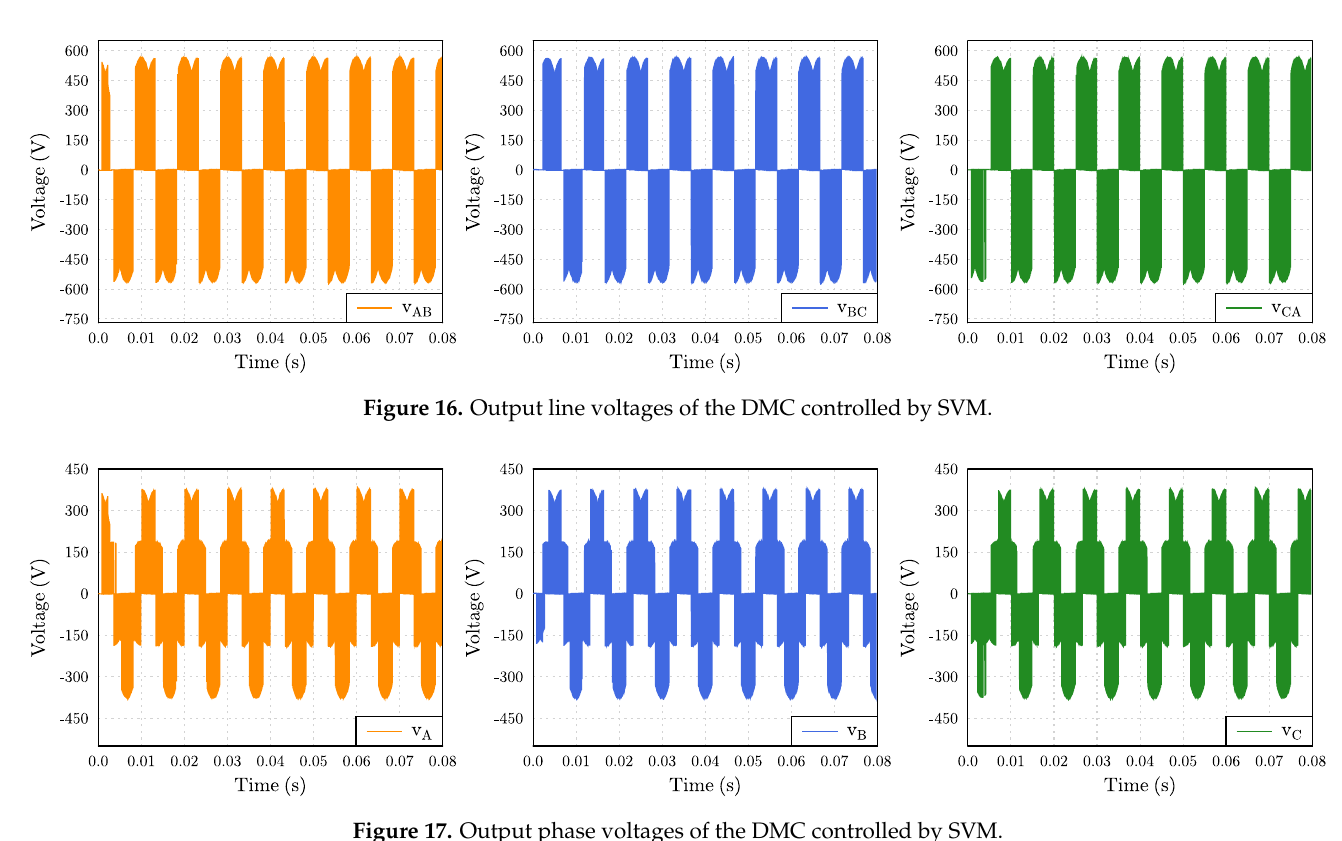
Figure 17. Output phase voltages of the DMC controlled by SVM.